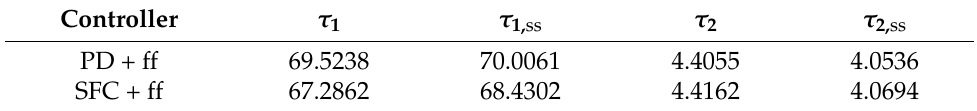
Table 6. RMS of applied torques comparative of the simulations with F C .